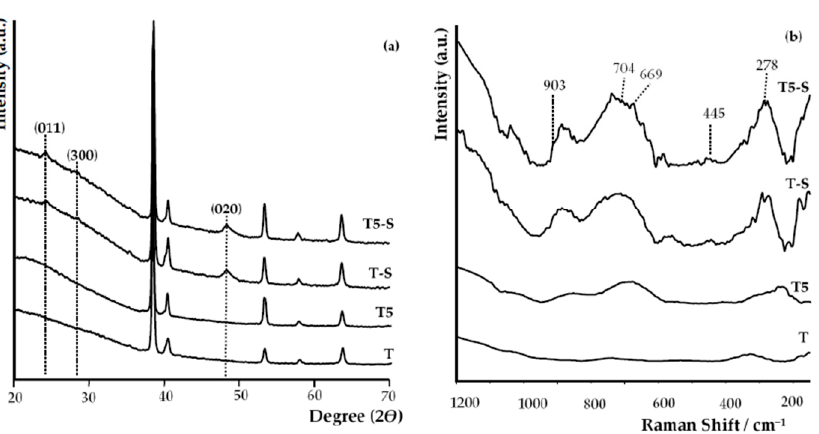
Figure 2. Energy-dispersive spectroscopy (EDS) spectra and quantitative data of the T ( a ), T5 ( b ),